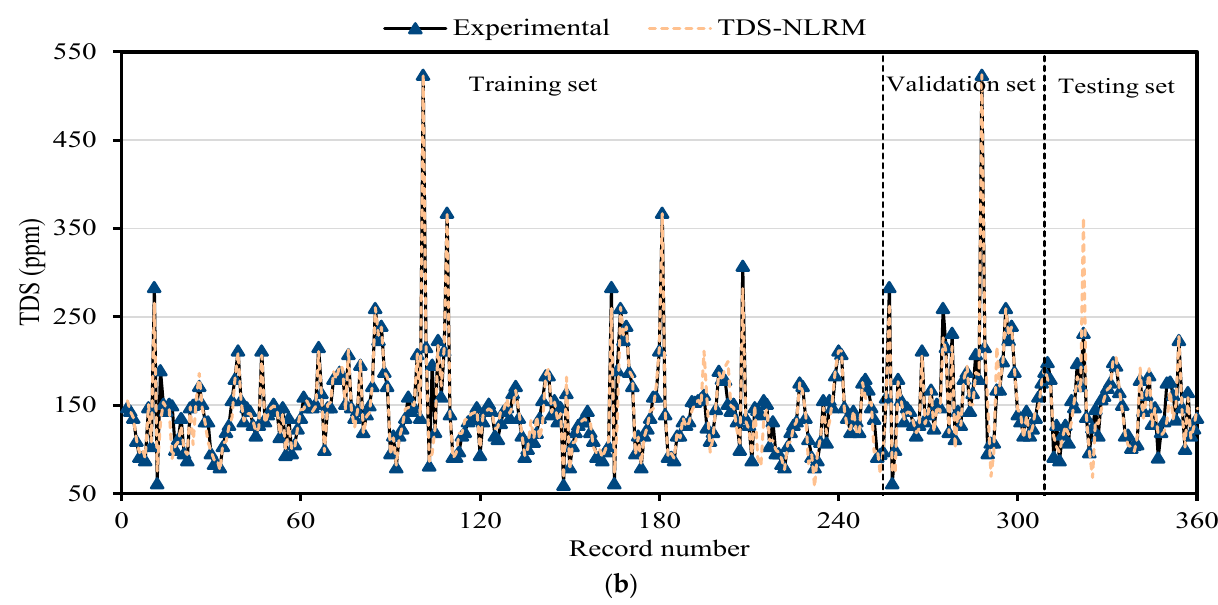
Figure 8. Deviation of observed and predicted results of NLRMs ( a ) EC; ( b ) TDS.